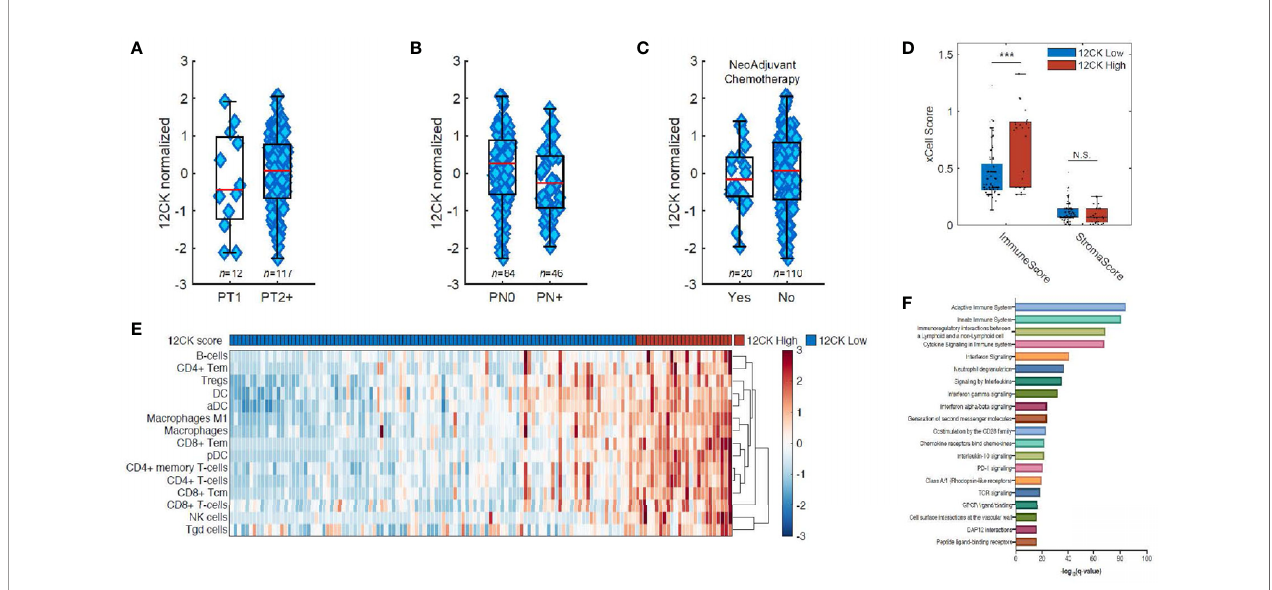
FIGURE 3 | Implications of the 12-chemokine score. The 12-CK scores were found to be independent of traditional prognostic indicators, such as pathologic (A) T-staging and (B) N-staging, as well as to (C) the receipt of neoadjuvant chemotherapy. (D) High 12-CK scores were furthermore related to elevated immune scores, but not stromal scores as delineated by the gene signature-based deconvolution method xCell. (E) Furthermore, 12-CK high tumors highly expressed signatures related to both innate and adaptive immune cells. (F) On gene set enrichment analysis, high 12-CK tumors expressed gene sets related to TCR signaling, CD28 co-stimulation, IFN- g signaling, IFN- a / b signaling, cytokine signaling, chemokine receptor binding and neutrophil degranulation. ***p < 0.001. NS, Non-signi fi